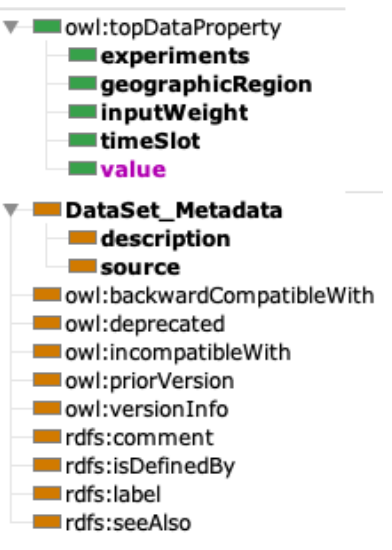
Figure 7. Main object properties in Protege [43].